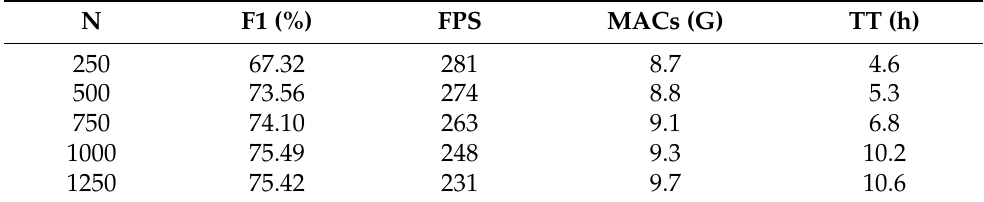
Table 5. The efficiency trade-offs of different anchor line numbers on CULane using the ResNet-18 backbone.“TT” represents the training time in hours.